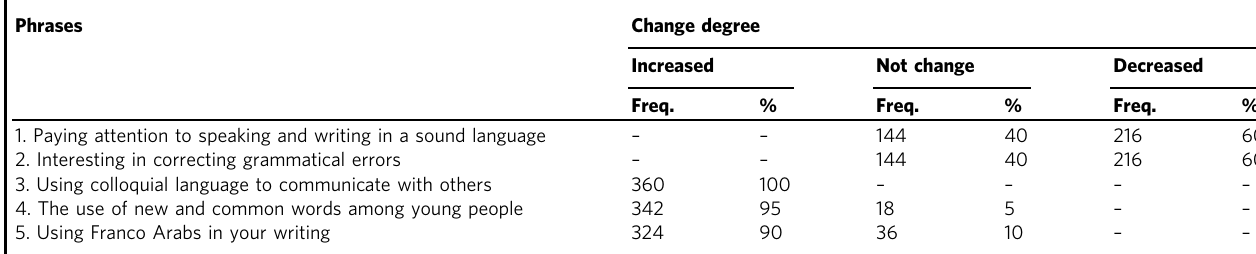
Table 3 Respondents ’ responses according to the change in the cultural identity component of language and the method of dialog with